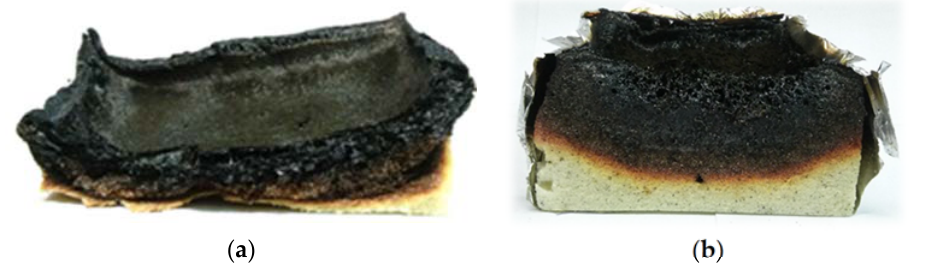
Figure 6. Digital images. ( a ) PU–0; ( b ) PU–EG after cone calorimeter test.